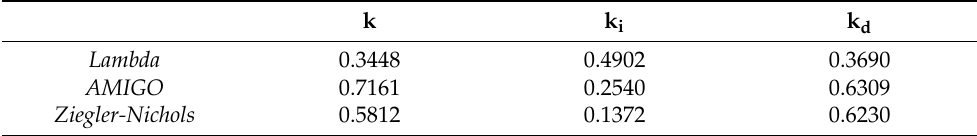
Table 6. PID parameters according to the average values from the step responses with an additional load of 6.1 g.